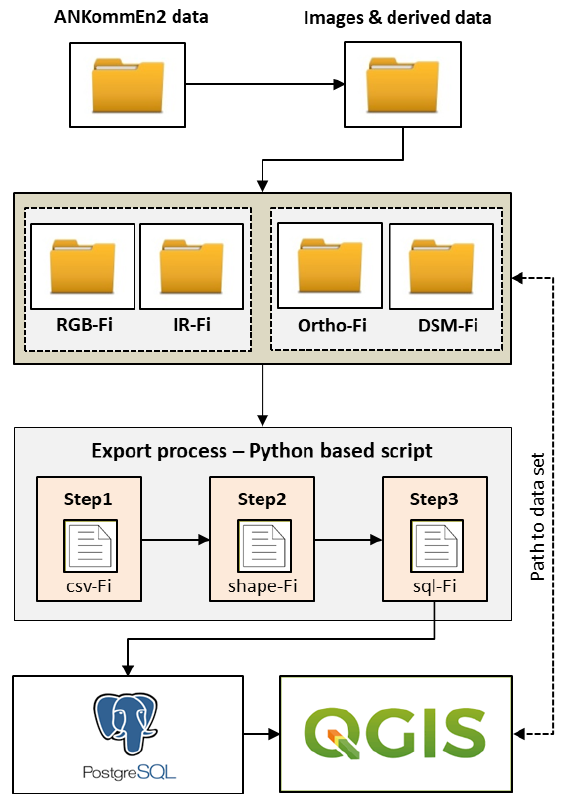
Figure 14: Storage process of images and the derived data in Postgres/PostGIS and viewing in QGIS